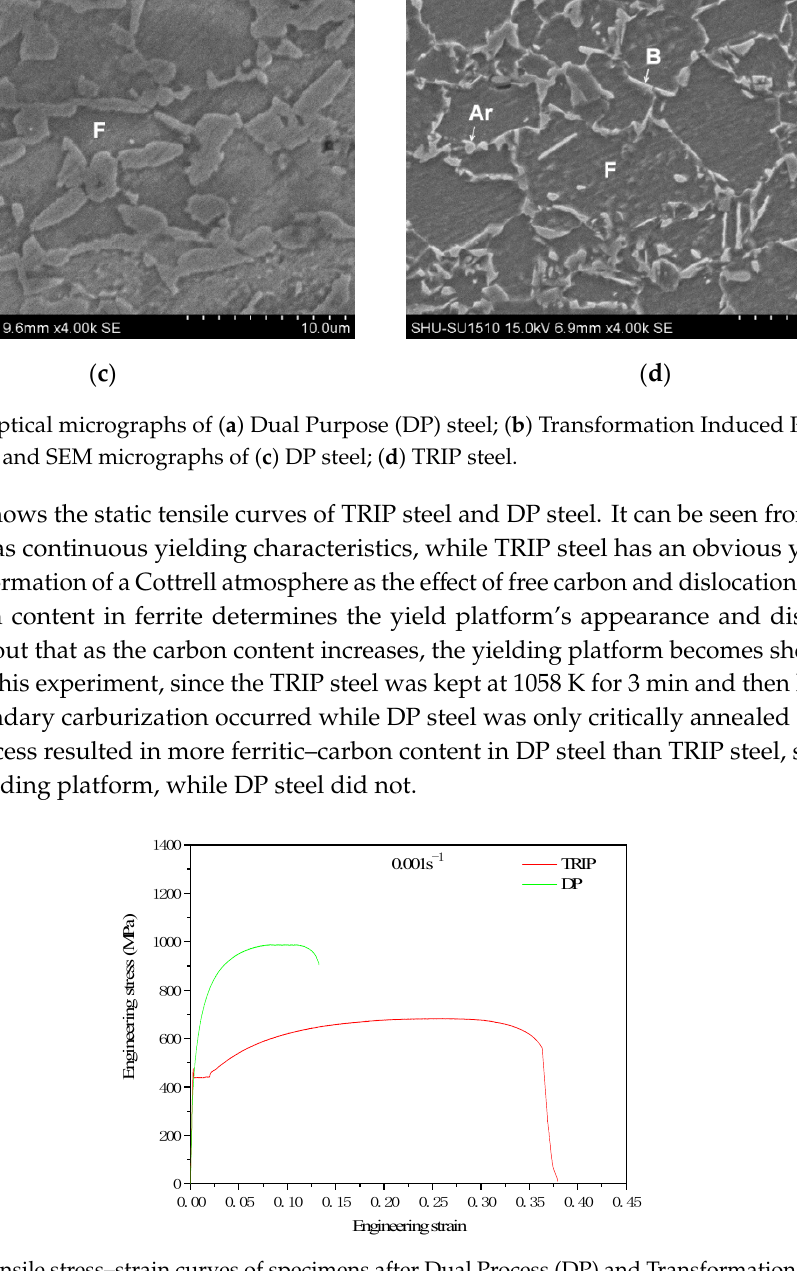
Figure 4. Tensile stress–strain curves of specimens after Dual Process (DP) and Transformation Induced Plasticity (TRIP) heat treatments.